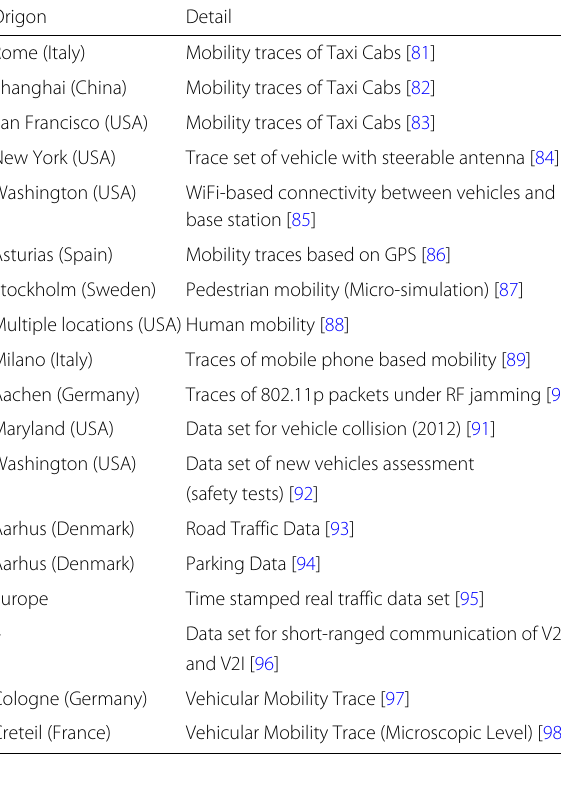
Table 4 Available mobility